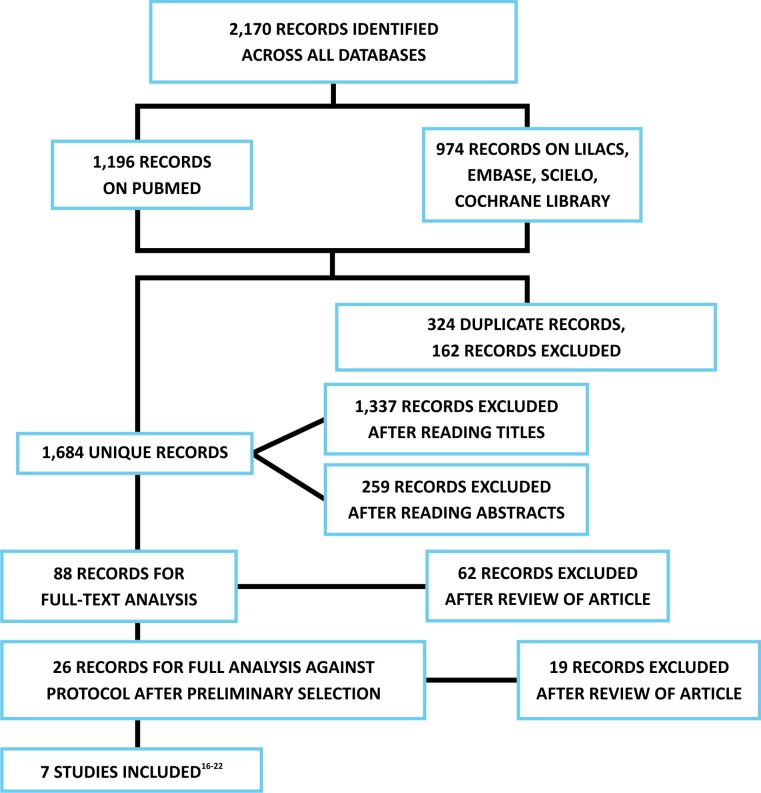
Summary of results of searches on electronic databases.